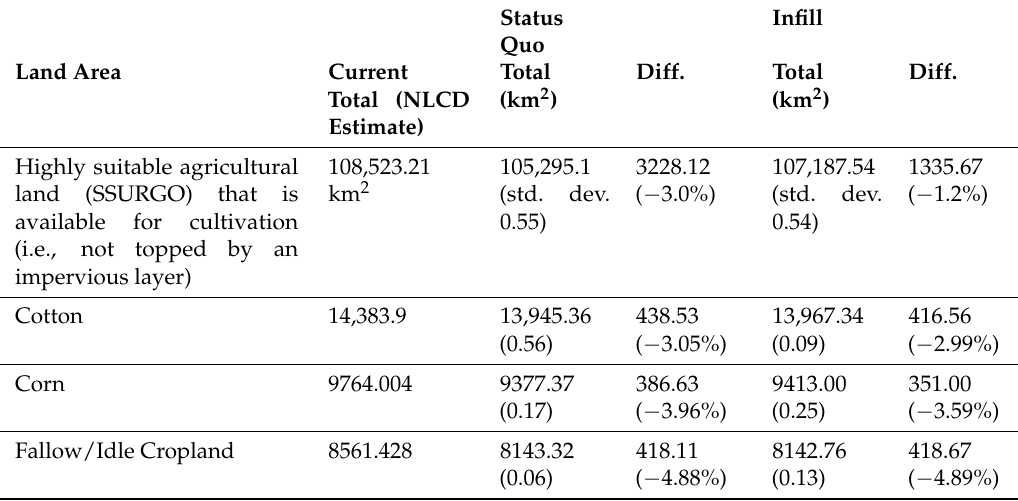
Table A2. Change to farmland and ecologically significant areas (average simulated 2050/total 2011) under the SQ and Infill urban growth